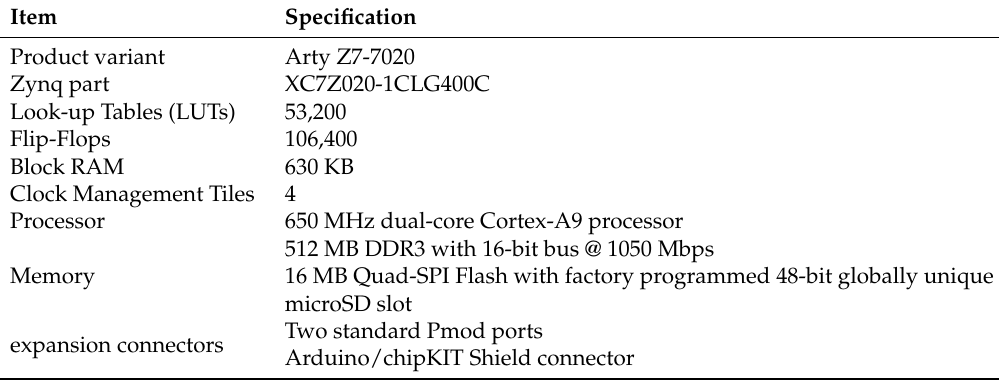
Table 1. Some specifications of Arty Z7-7020 development